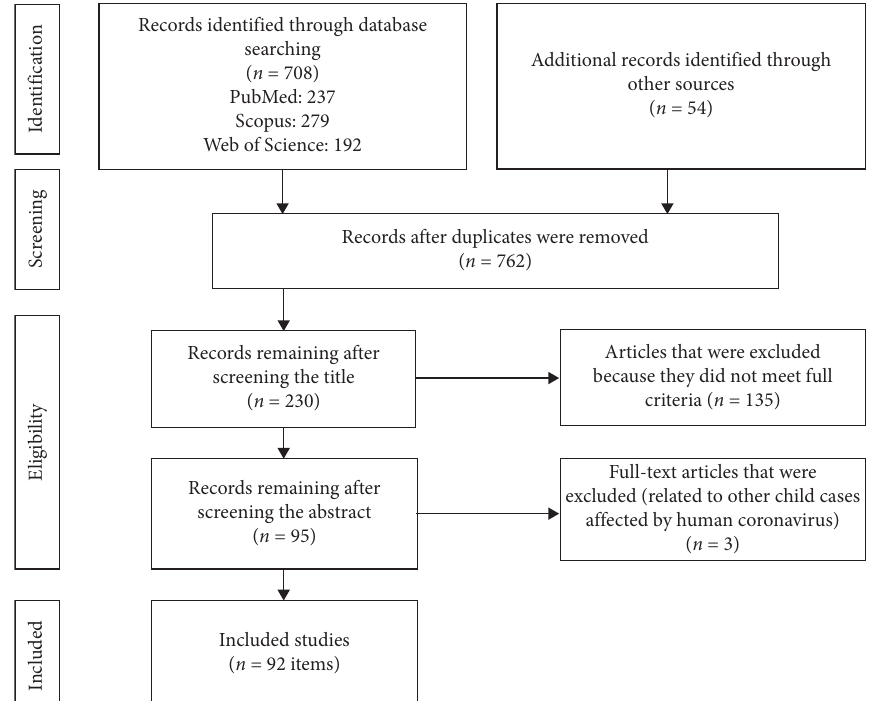
Figure 1: PRISMA flow diagram for the scoping review